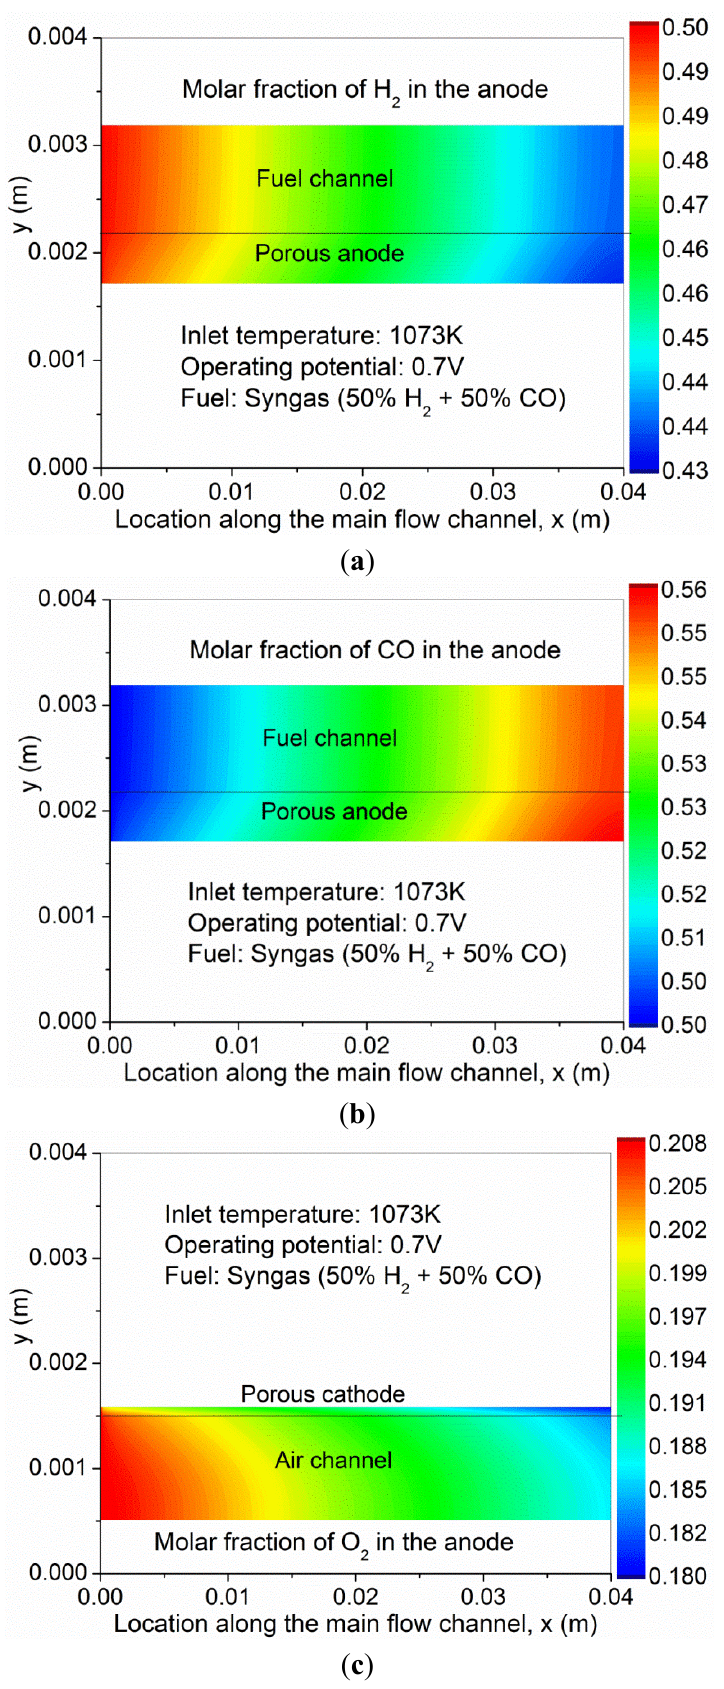
; ( b ) CO; and ( c ) O 2 2